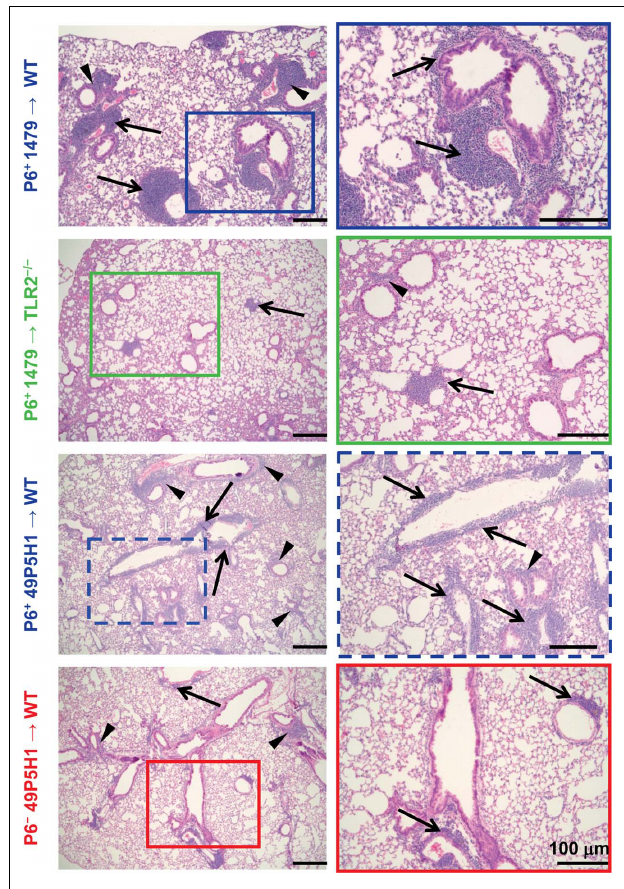
FIGURE 1 |Absence of hostTLR2 or bacterial P6 limits immune cell infiltration. Mice were exposed to NTHI for 16 consecutive weeks. H&E stained lung sections were analyzed for inflammation by light microscopy. Representative images of H&E sections taken from five mice per group. Images in the right column are enlarged magnification of the outlined region. Immune cell infiltrates surrounding perivascular (arrows) and peribronchial (arrowheads) regions are